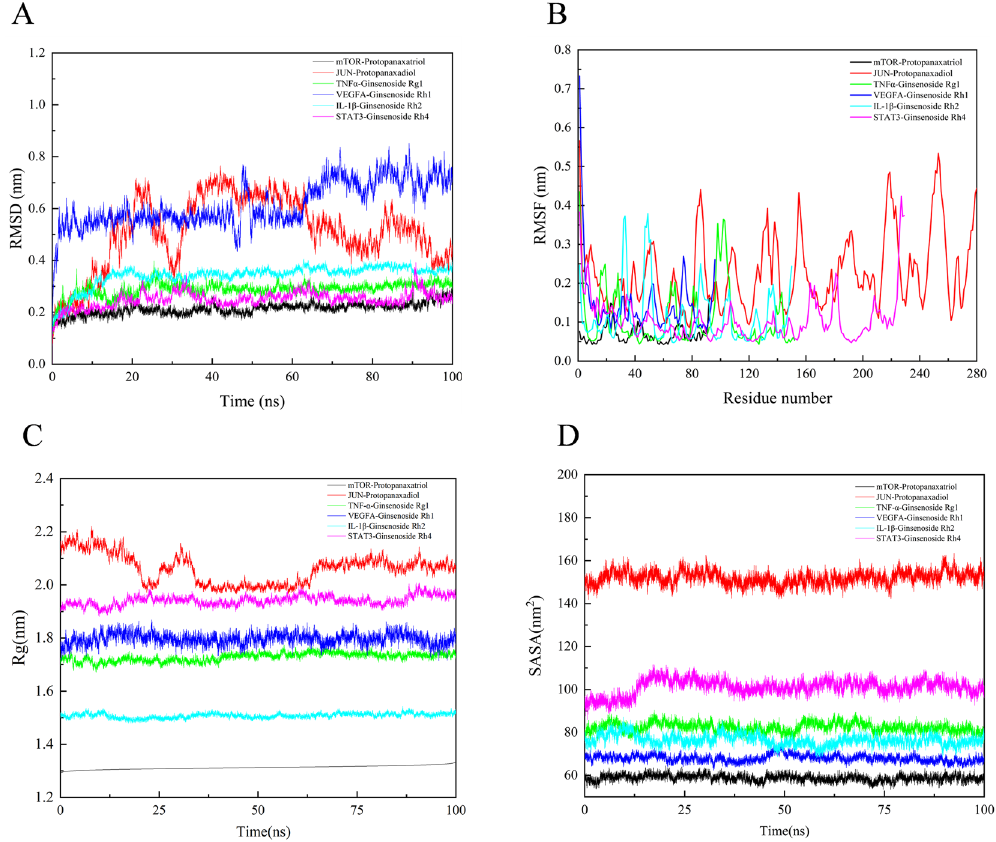
Figure 6. Profiles of molecular dynamics simulations. RMSD analysis for the protein–ligand complexes ( A ). RMSF analysis for the protein–ligand complexes ( B ). Rg analysis for the protein–ligand complexes ( C ). SASA analysis for the protein–ligand complexes ( D